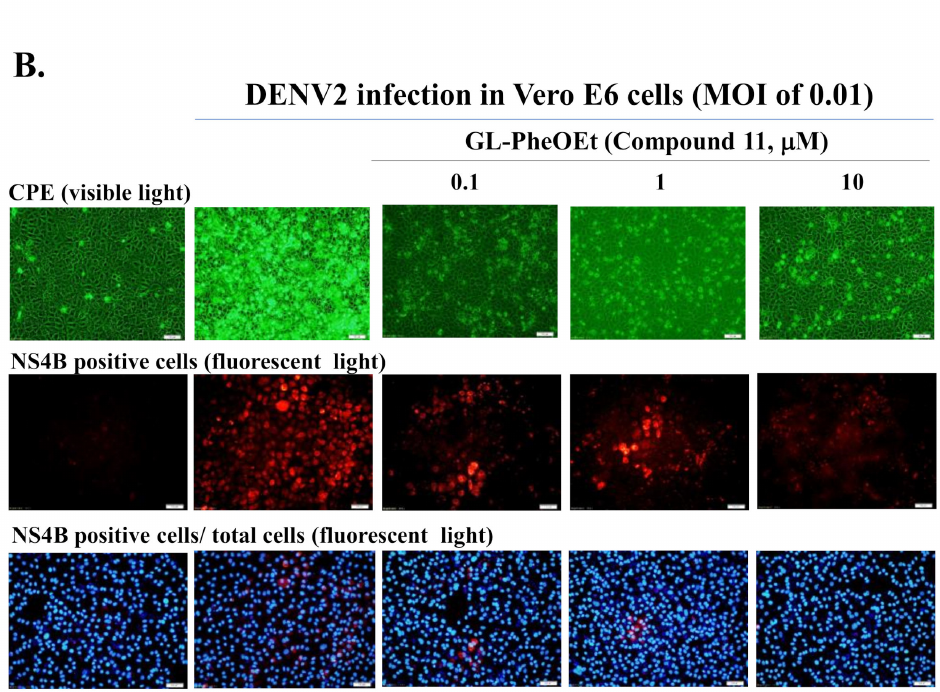
Figure 2. Inhibition of DENV2-induced cytopathic effects and DENV2 protein expression by GL- D-ValOMe (Compound 3 , ( A ) and GL-PheOEt (Compound 11 , ( B ) in Vero E6 cells. Cells were infected with DENV2 at an MOI of 0.01 and immediately treated with the indicated concentrations of Compounds 3 and 11 . Images of DENV2-induced cytopathic effect were photographed 96 h post-infection by light microscopy ( top ). Treated/infected Vero E6 cells were also analyzed using immunofluorescence staining with anti-DENV2 NS4B antibodies. DENV2 infectivity was discovered by the ratio of DENV2 NS4B positive cells ( middle ) to total cells stained with DAPI ( bottom ). Scale bar = 100 µ